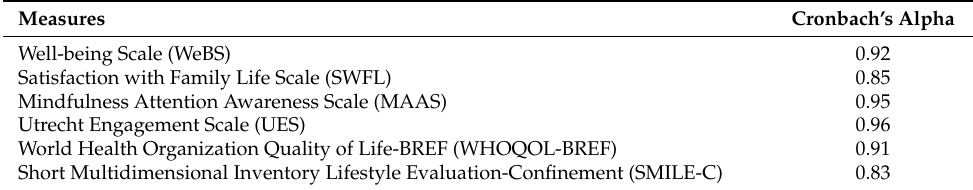
Table 1. Internal consistency reliability for measures used in this study.